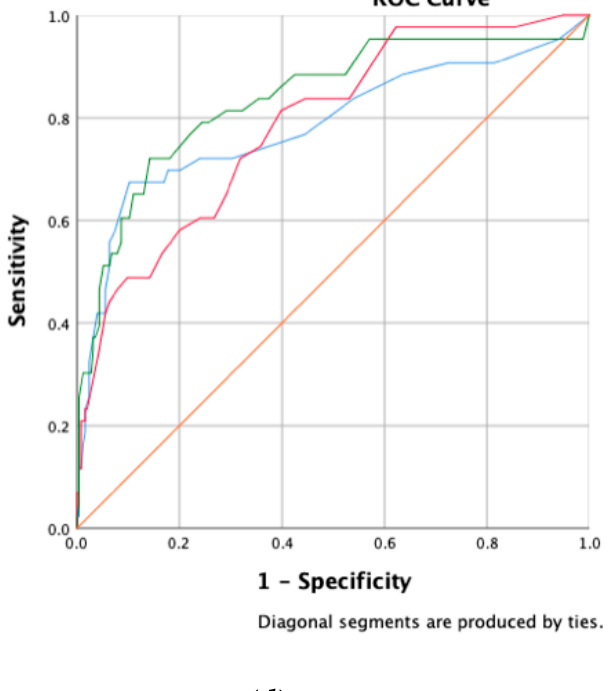
Figure 3. Receiver operating characteristic (ROC) curves for three pelvic asymmetry measures with calculated area under the curve (AUC) under 4 conditions: ( a ) discriminating between grade 0 (non-lame horses) and grades 1–4 (all lame horses), ( b ) discriminating between grades 0–1 and grades 2–4, ( c ) discriminating between grades 0–2 and grades 3–4 and ( d ) discriminating between grades 0–3 and grade 4.